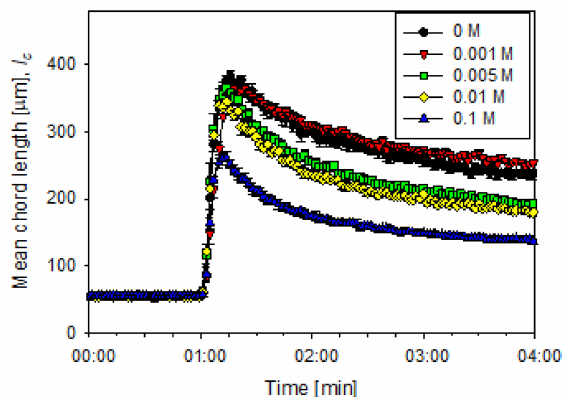
Figure 6. Evolution of the average size of aggregates of kaolin particles (chord length) before and after the addition of